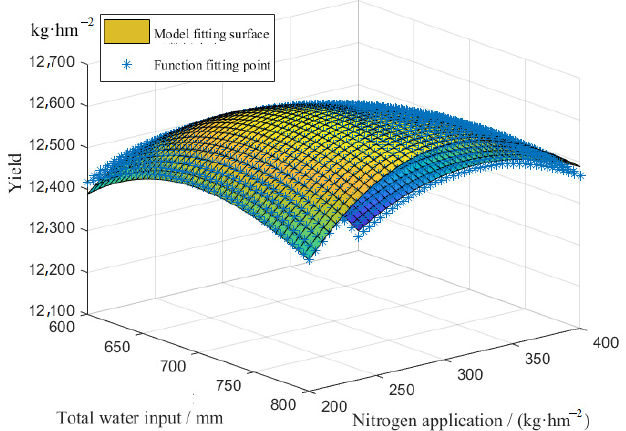
Figure 10. Fitting results for yield with the quadratic polynomial based on the values predicted by the Gaussian regression model. the Gaussian regression